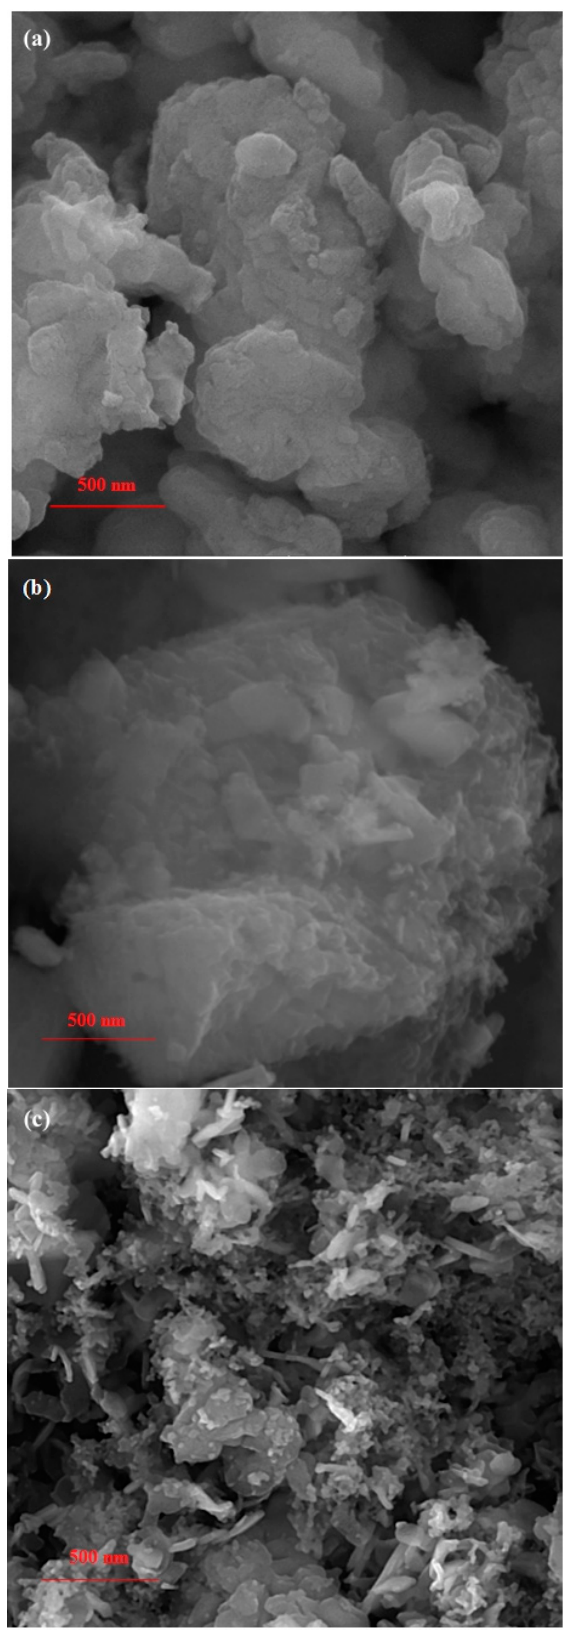
Figure 3. FESEM images of fresh: ( a ) synthesized calcium; and ( b ) Ca-9Co; and ( c ) Ca-9Co-4.5Y catalyst/sorbents.